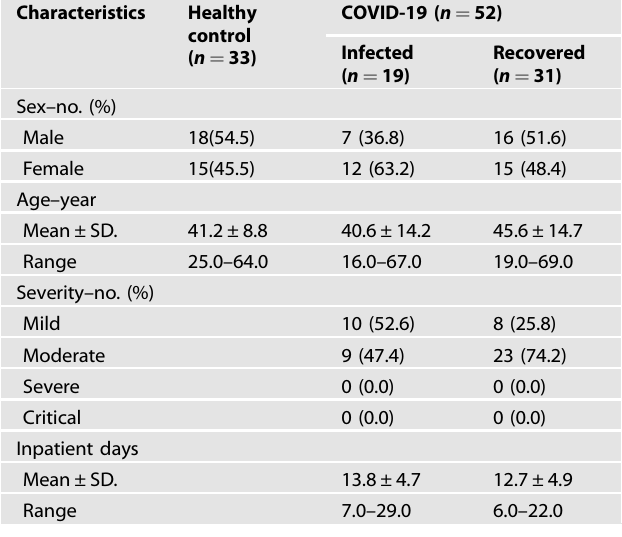
Table 1. Demographics and clinical characteristics of COVID-19 patients.